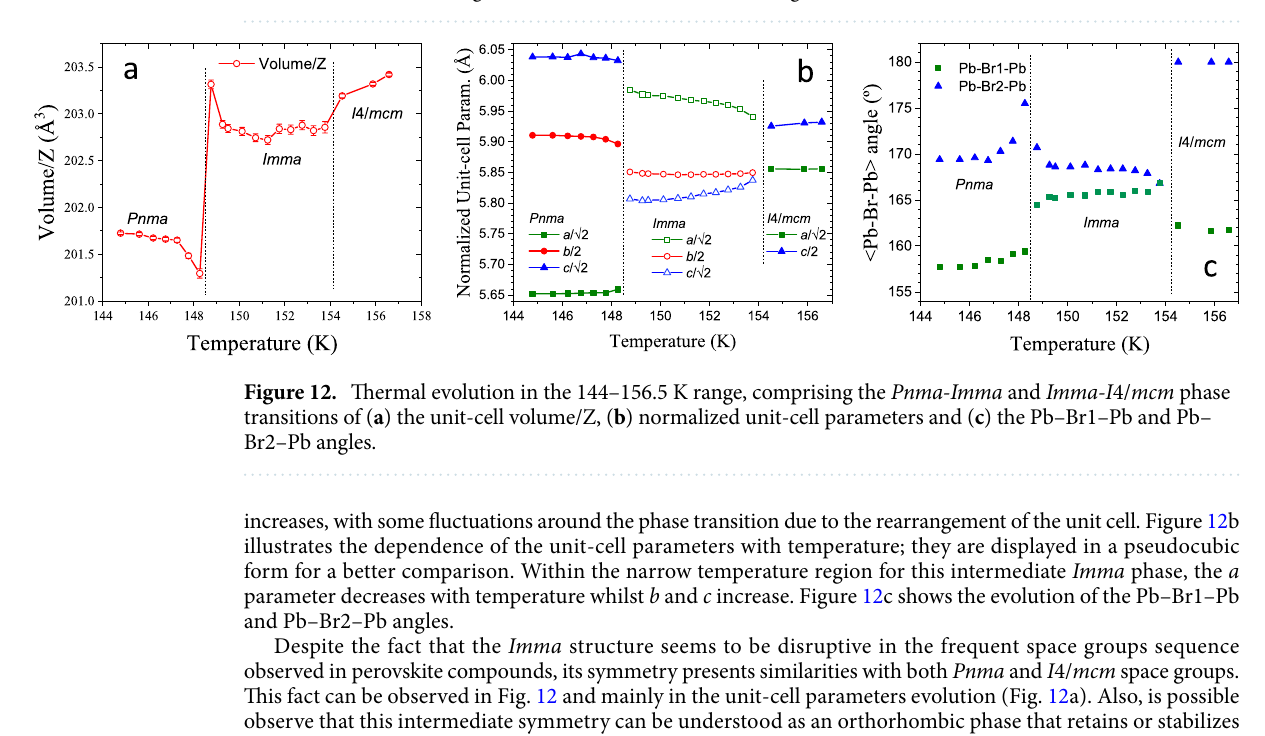
Figure 11. Views of the Imma crystallographic model with the two possible configurations for the MA organic units: ( a ) delocalized along the b axis and ( b ) delocalized along the a axis.